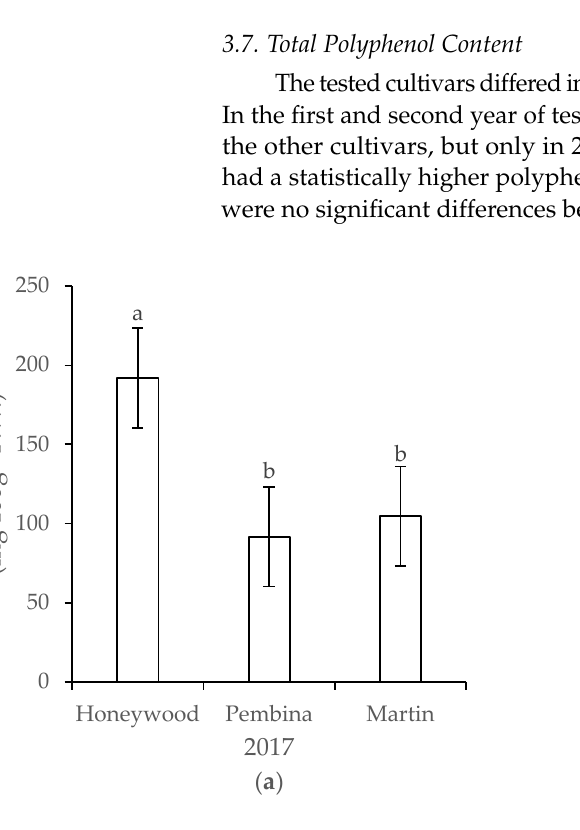
Figure 8. Total flavonoid content in the fruits of the studied cultivars in ( a ) 2017 and ( b ) 2018. Values with different letters are significantly different within a year. 3.9. Anthocyanin Content The anthocyanin content of the fruits depended on the cultivar (Figure 9a,b). In the first year of study, ‘Pembina’ was poorer in anthocyanins than the other two cultivars.